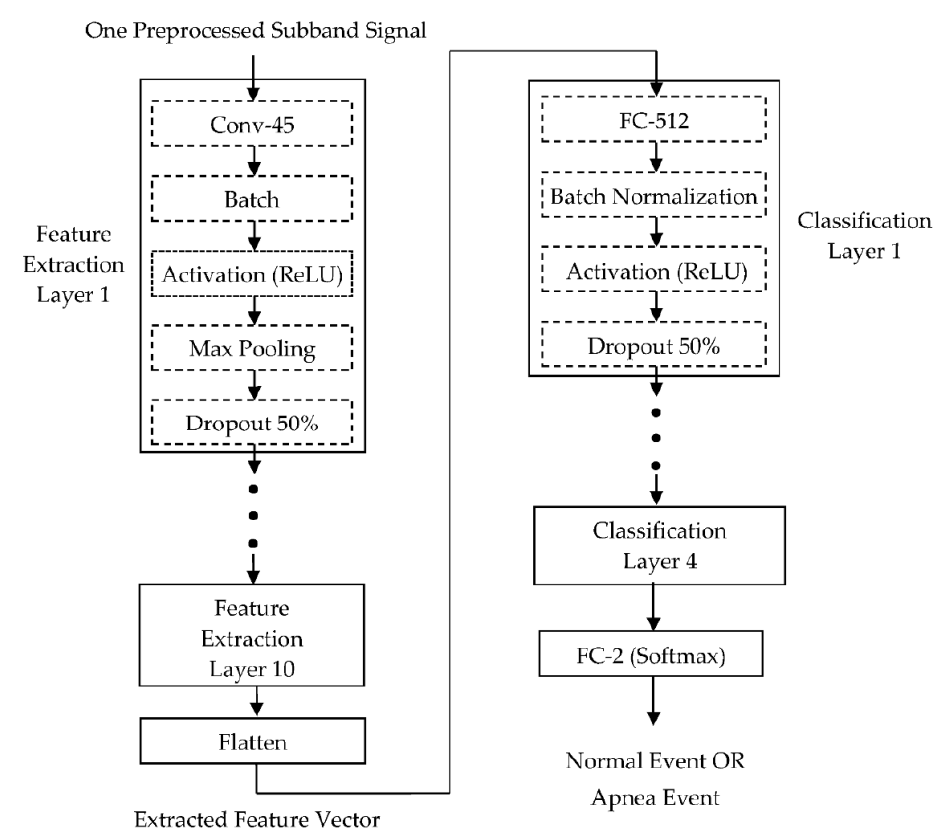
Figure 6. Block diagram of the 1D deep CNN model for identifying normal and apnea